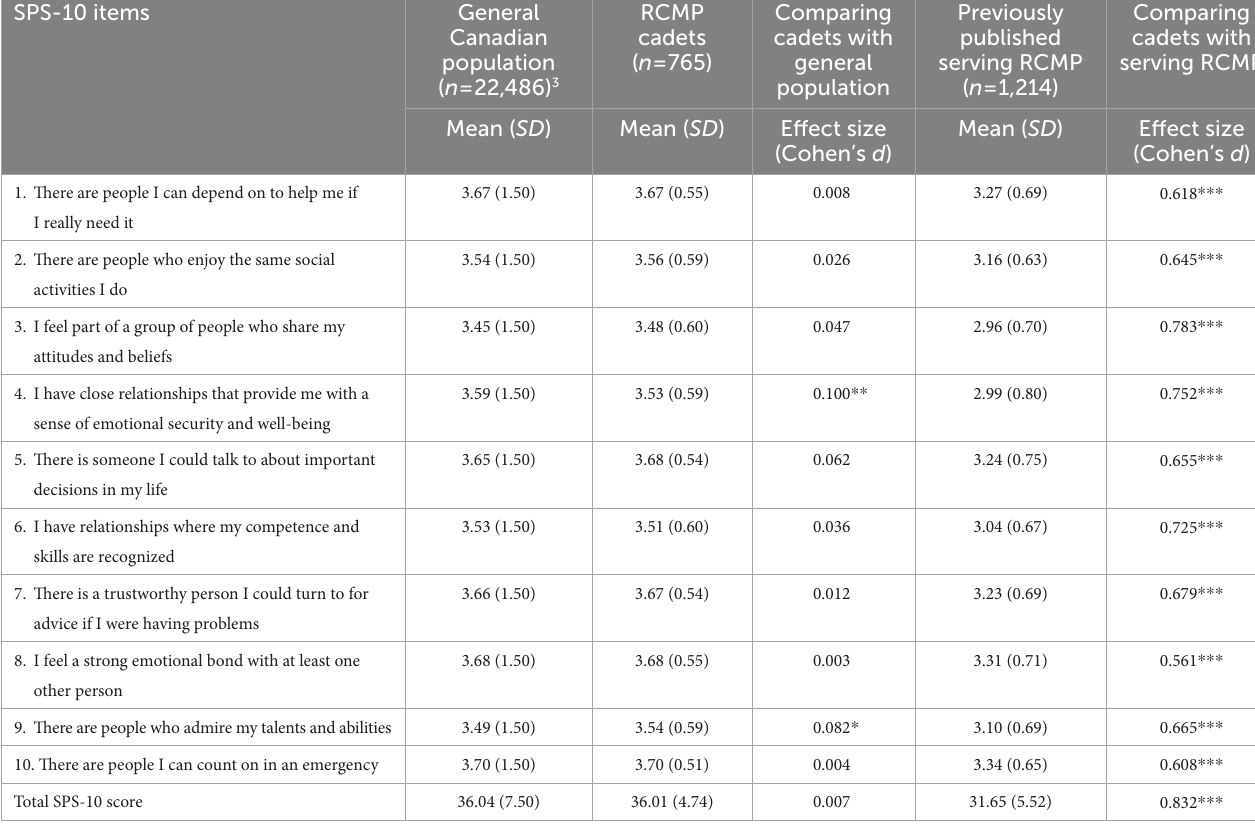
TABLE 3 Comparing mean social support scores of RCMP Cadets with the Canadian Population and serving RCMP. SPS-10 items